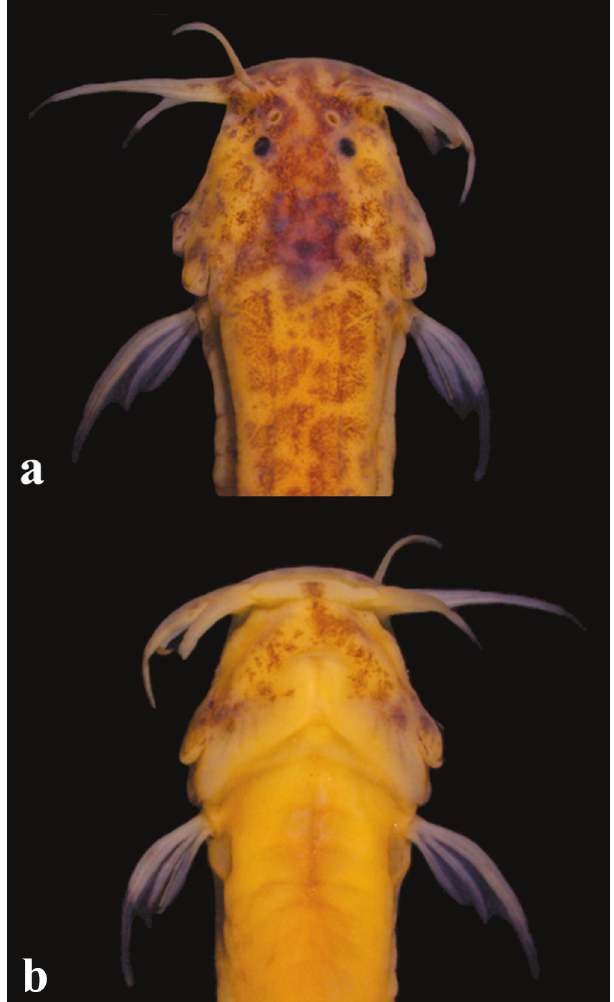
Fig. 2. Head detail of Listrura camposi , MZUSP 95189, 46.4 mm SL in ( a ) dorsal and ( b ) ventral